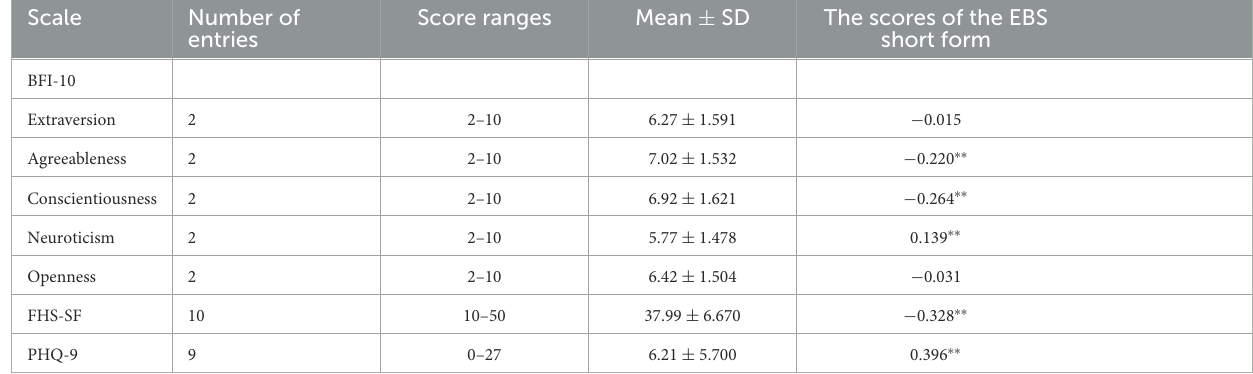
TABLE 4 The scores of the BFI-10, FHS-SF, and PHQ-9 Scale of the participants and their correlation with the scores of the EBS short form. Scale Number of Score ranges Mean ± SD The scores of the EBS entries